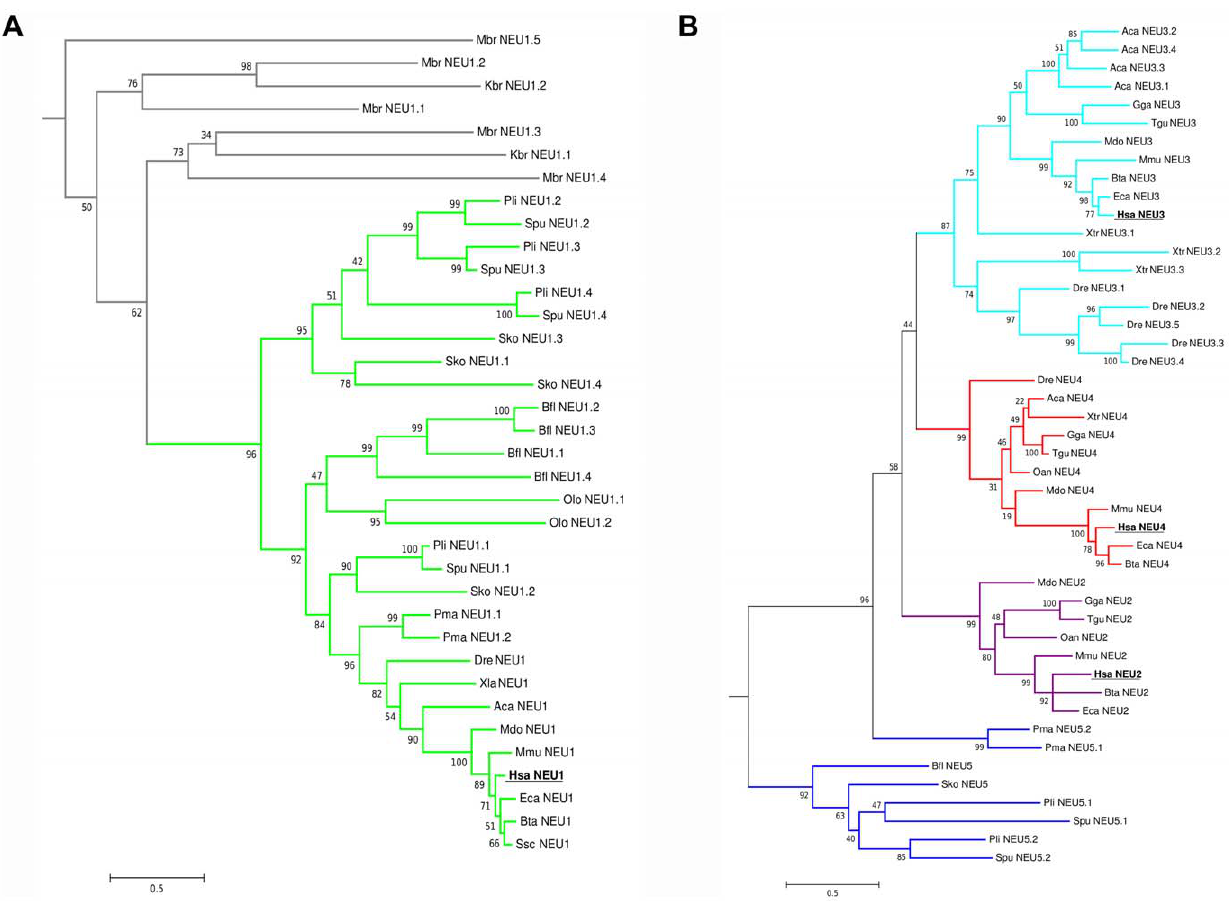
Figure 9. NEU1 and NEU2–5 phylogenetic subtrees in sialidase protein family. Detailed view of the phylogenetic subtrees of NEU1 sialidase subgroup (A) and of the other subgroups (B). The newly identified NEU5 subgroup emerges at the root of the NEU2, 3 and 4 subclasses. Bootstrap values are indicated for every node. Color code is used for different subclasses: NEU from protist K. brevis and from choanoflagellate M. brevicollis in grey, NEU1 in green, NEU2 in purple, NEU3 in cyan, NEU4 in red, NEU5 in blue. The tree is drawn to scale, with branch lengths measured in the number of substitutions per site.